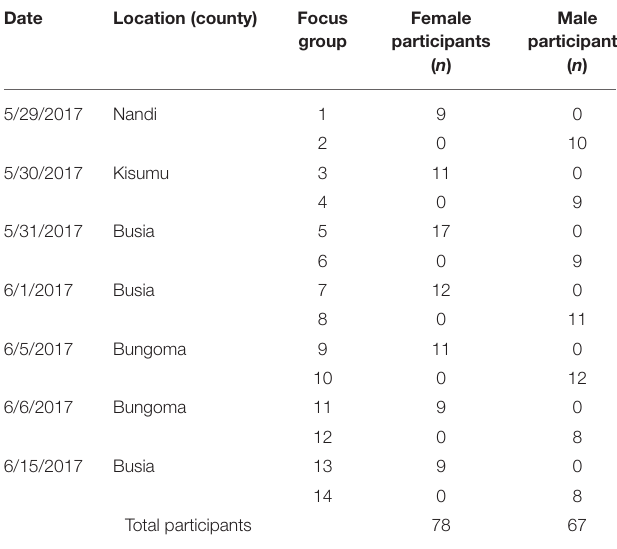
TABLE 1 | Focus group discussions: dates, locations, and participant